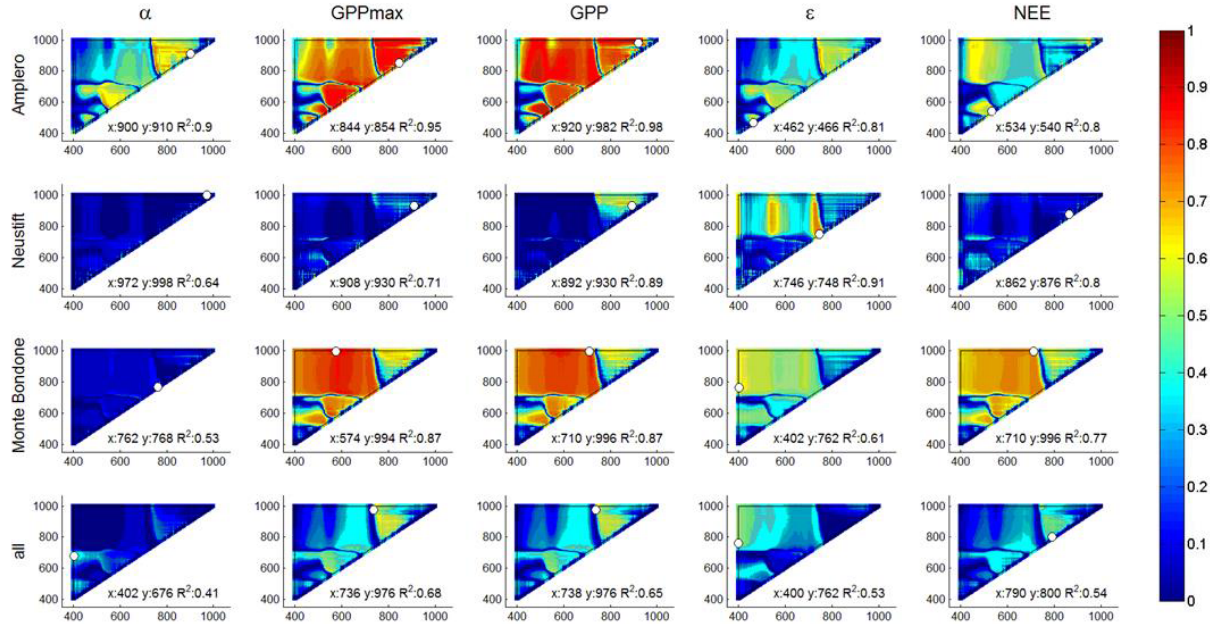
Figure 3. Correlograms of R 2 values for α , GPP max , midday averaged GPP, ε and NEE, on the one hand, and NSD-type indices for Amplero, Neustift, Monte Bondone (both study years pooled) and all sites pooled on the other. The white dots indicate the position of paired band combinations corresponding to the maximum R 2